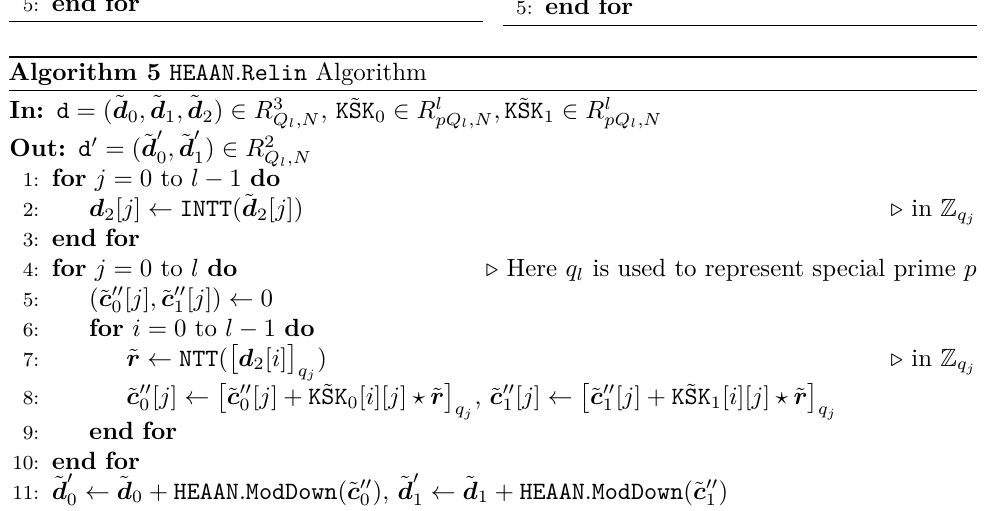
Algorithm 5 HEAAN . Relin